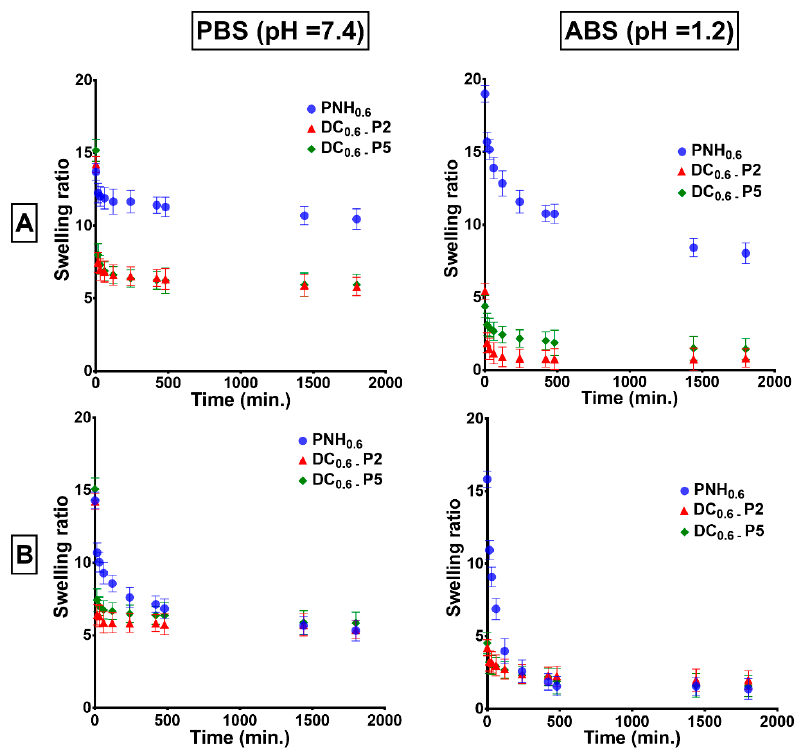
Figure 7. Deswelling kinetics of conventional (PNH 0.6 ) and double cross-linked hydrogels measured in buffer solutions in the presence of 1 mg/mL ( A ) and 5 mg/mL ( B ) of Met aqueous solutions. The swelling/deswelling repeatability of the DC hydrogel between ABS and PBS solutions is depicted in Figure 8. Due to the porous structure, the polymeric 3D structures were capable of absorbing and desorbing the aqueous solution from the medium quickly upon pH change from basic to acidic conditions and the reverse. However, the time for swelling was longer than that for deswelling, because, during protonation of the carboxylic groups, the swollen network collapsed, mechanically expelling a large amount of water, as explained above.